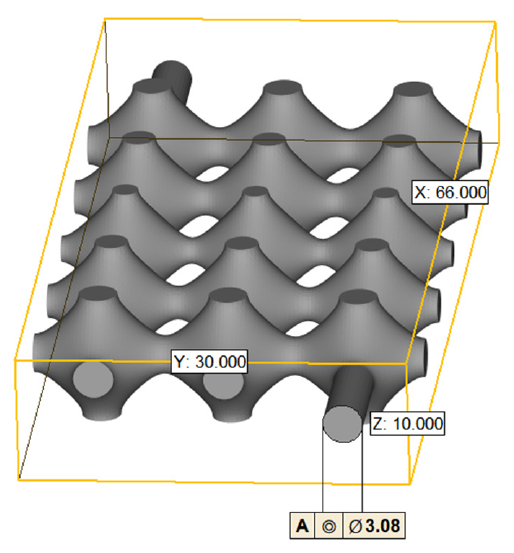
Figure 1. TPMS vascular flow path model.